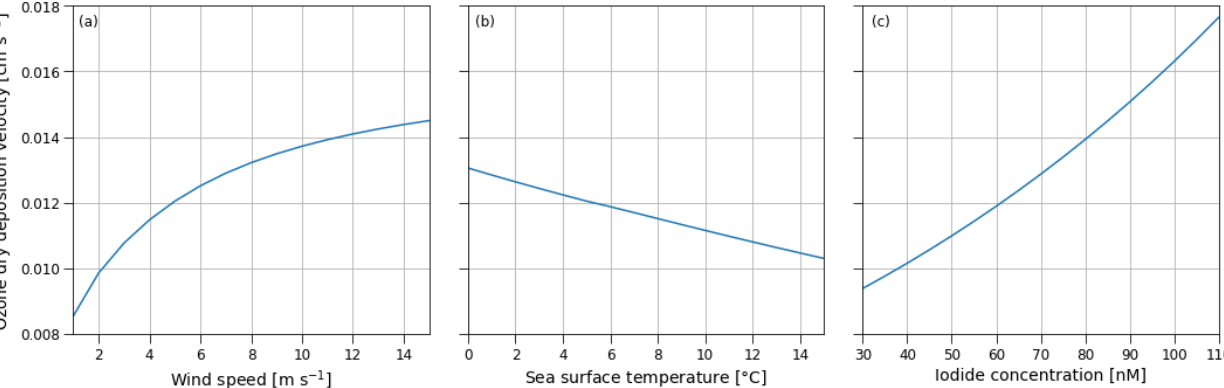
Figure B1. Sensitivity of the ozone dry-deposition velocity from COAREG to the environmental factors 10m wind speed (ms − 1 ) (a) , sea surface temperature ( ◦ C) (b) and sea surface iodide concentration (nM) (c) using typical values of 10m wind speed, sea surface temperature and iodide concentration of 5ms − 1 , 5 ◦ C and 60nM, respectively. Note that the sensitivity to sea surface temperature does not include effects of increasing reactivity but mostly represents the effect of reduced solubility (Eq. B2).